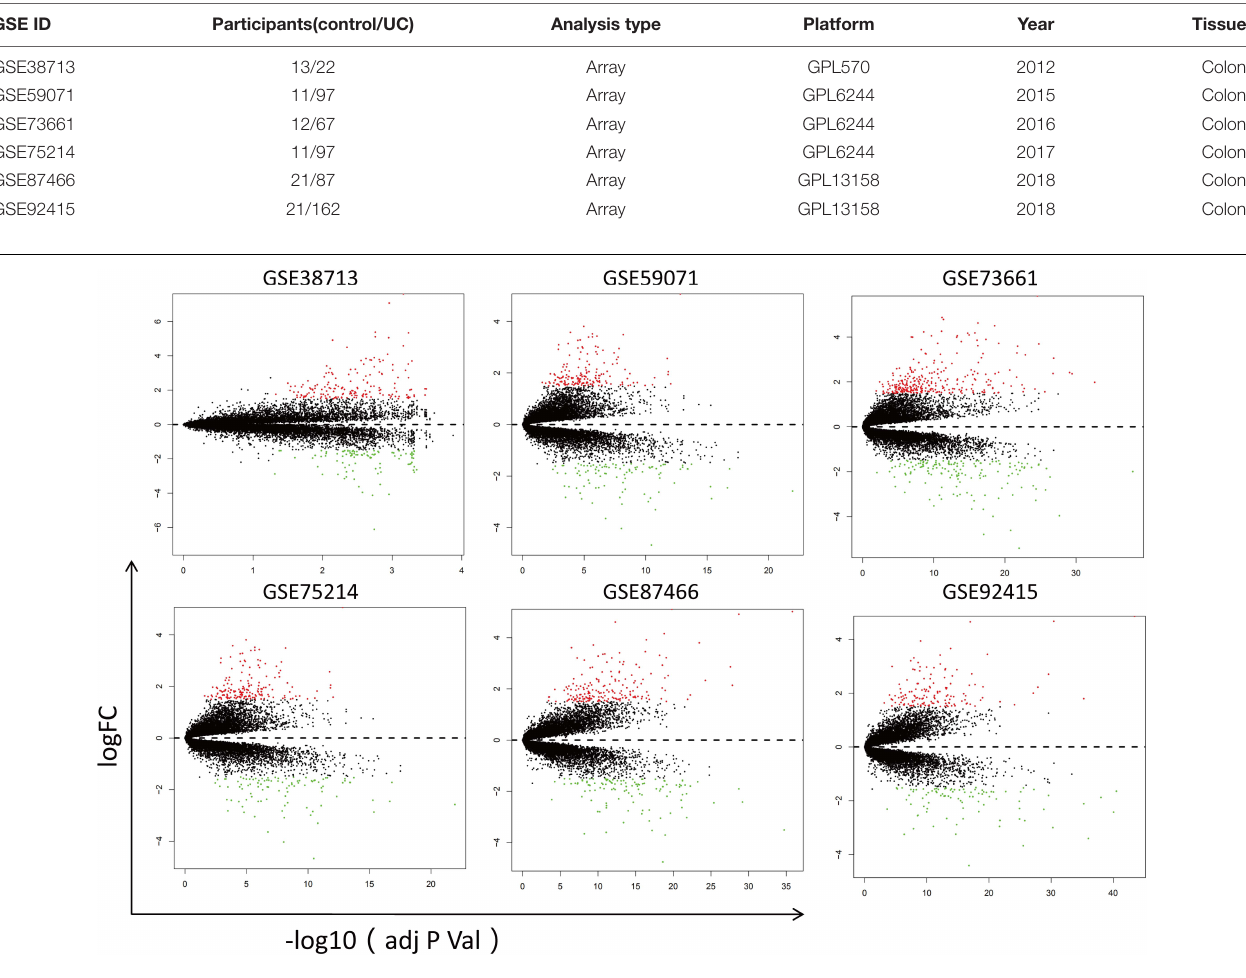
FIGURE 2 | Volcano maps of the six datasets. Red points represent upregulated genes, while green points represent downregulated genes. Black points indicate genes with no significant difference.